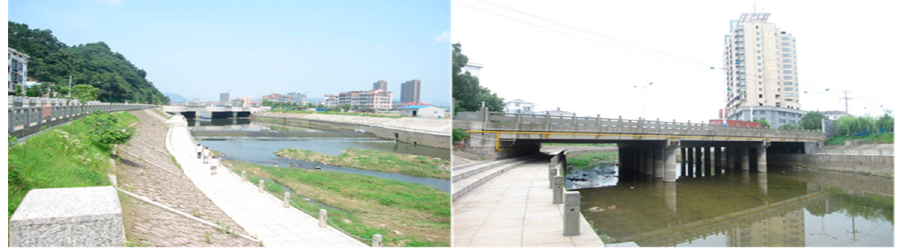
Figure 4. Hydrophilic platform, an example of supposedly ecological measures.